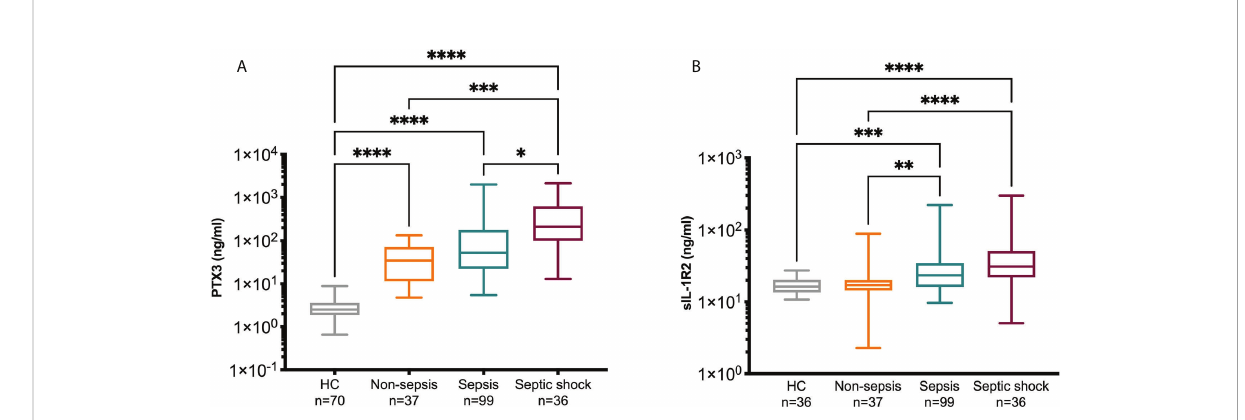
FIGURE 2 PTX3 and sIL-1R2 levels on day 1. PTX3 (A) and sIL-1R2 (B) plasma concentration were measured in non-sepsis, sepsis and septic shock patients admitted to ED. A group of healthy controls (HC) was also included. Kruskal-Wallis equality-of-populations rank test was used for the